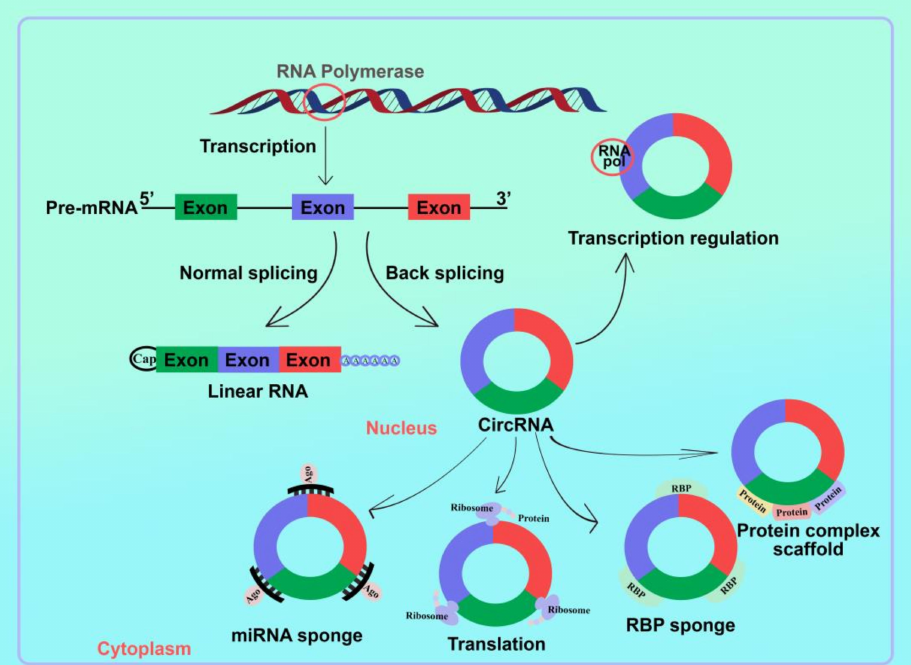
Figure 1. The function of circRNAs’; miRNA molecular sponging: circRNAs with miRNA binding sites can prevent miRNA from attaching to its target mRNA and hence prevent miRNA from inhibiting the target protein. Regulation of translation: circRNAs to bind to the ribosome in order to regulate translation. RBP sponging: circRNAs with an RBP binding site can regulate protein activity. Protein complex scaffold: circRNAs may serve as protein